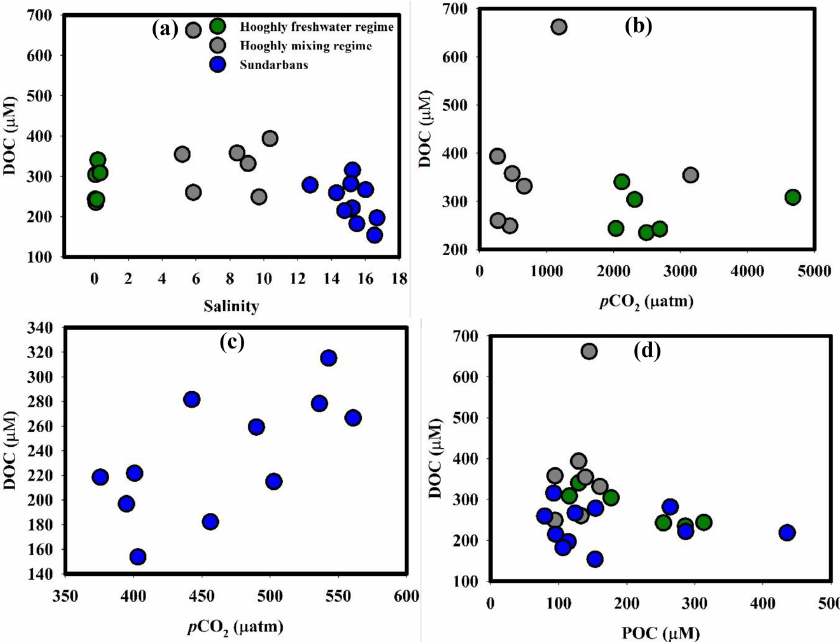
Figure 4. (a) DOC–salinity in the Hooghly–Sundarbans system, (b) DOC– p CO 2 in the Hooghly, (c) DOC– p CO 2 in the Sundarbans and (d) DOC–POC in the Hooghly–Sundarbans